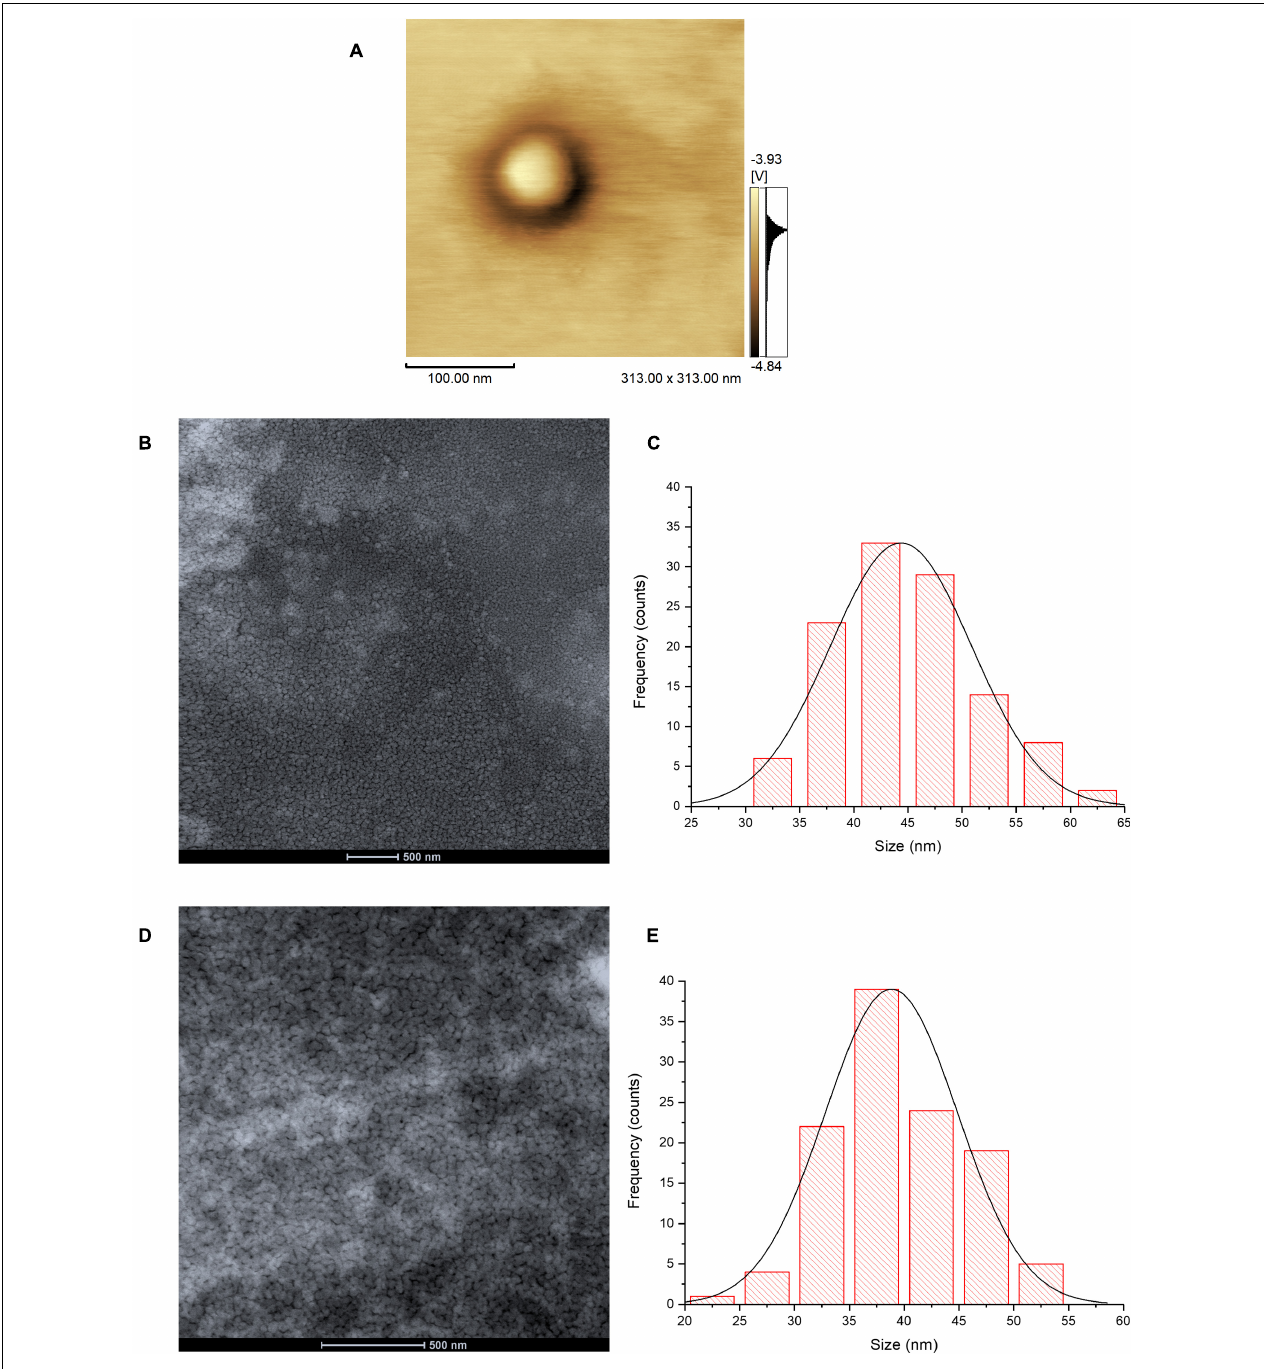
FIGURE 1 | Atomic force microscopy image of HNP in phase mode (A) ; Cryo-TEM images of HNP (B) and P-HNP (D) ; size distribution histograms of HNP (C) and P-HNP (E) .